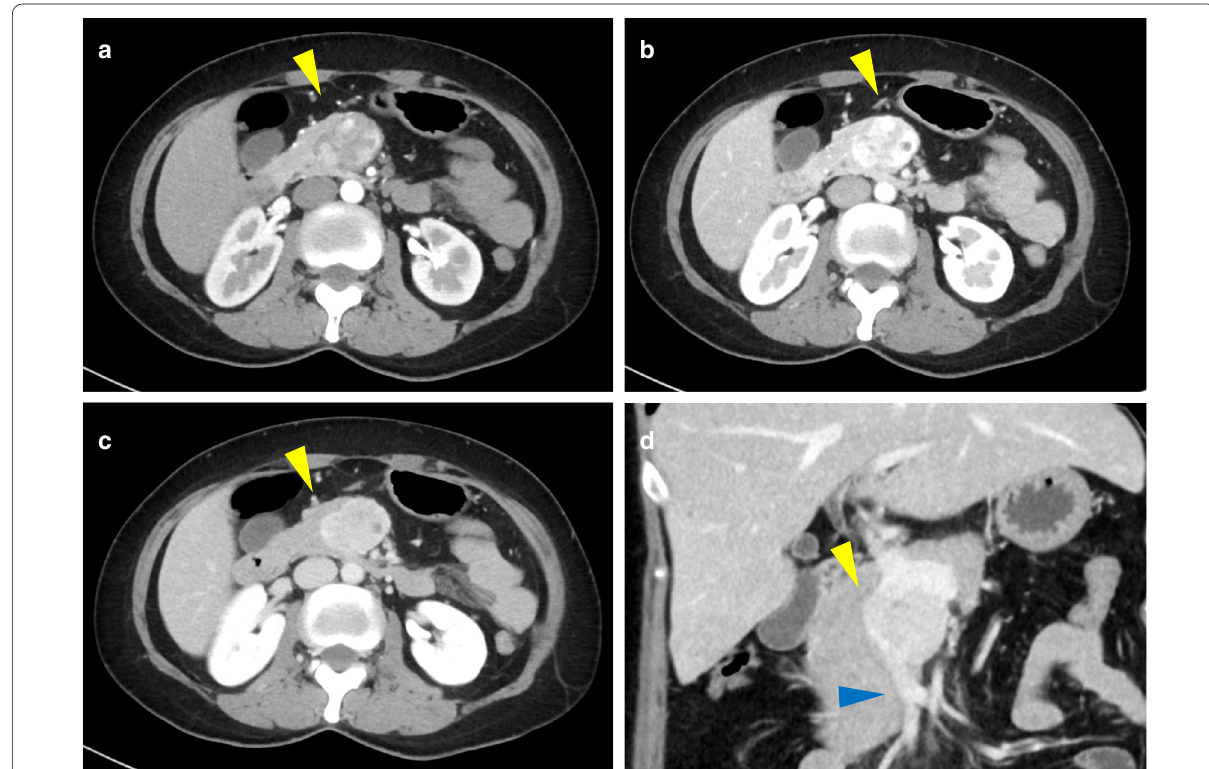
Fig. 1 Dynamic-CT scan ( a early arterial phase, b late arterial phase, c and d portal phase). Dynamic-CT scan revealing a hypovascularized tumor (yellow arrowhead) invading the superior mesenteric vein (blue